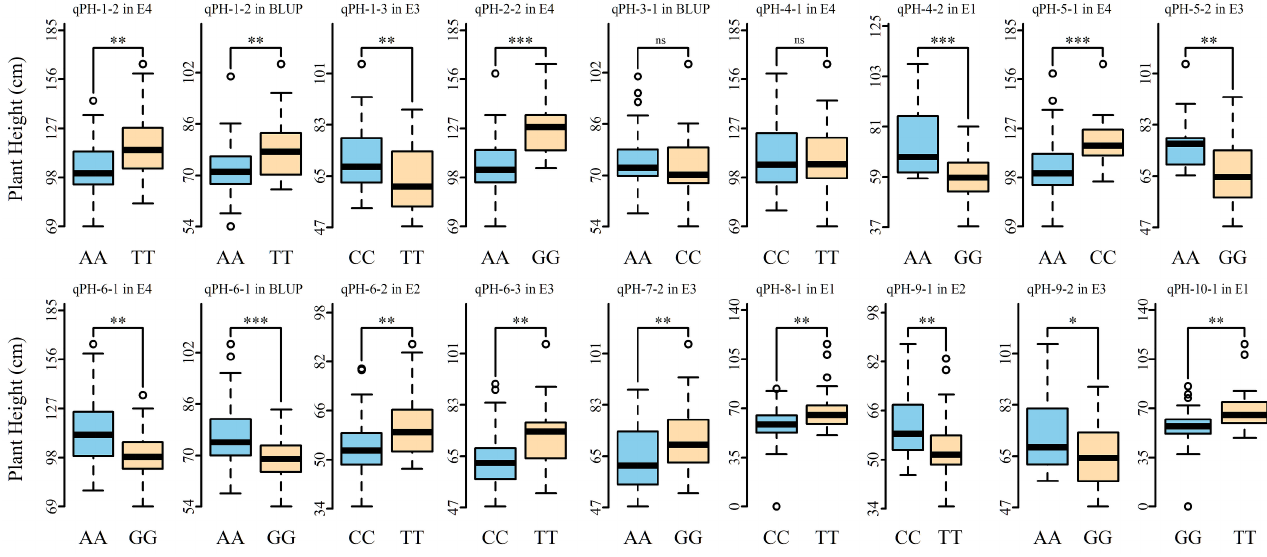
Figure 5. Plant height differences between elite and alternative alleles of each QTN of tobacco in different environments. E1-13H: Hukou (2013), E2-14-H: Hukou (2014), E3-14X: Xikou (2014), and E4-15X: Xikou (2015). *, **, and *** represent 0.05, 0.01, and 0.001 significance levels, respectively. ns: non-significant.